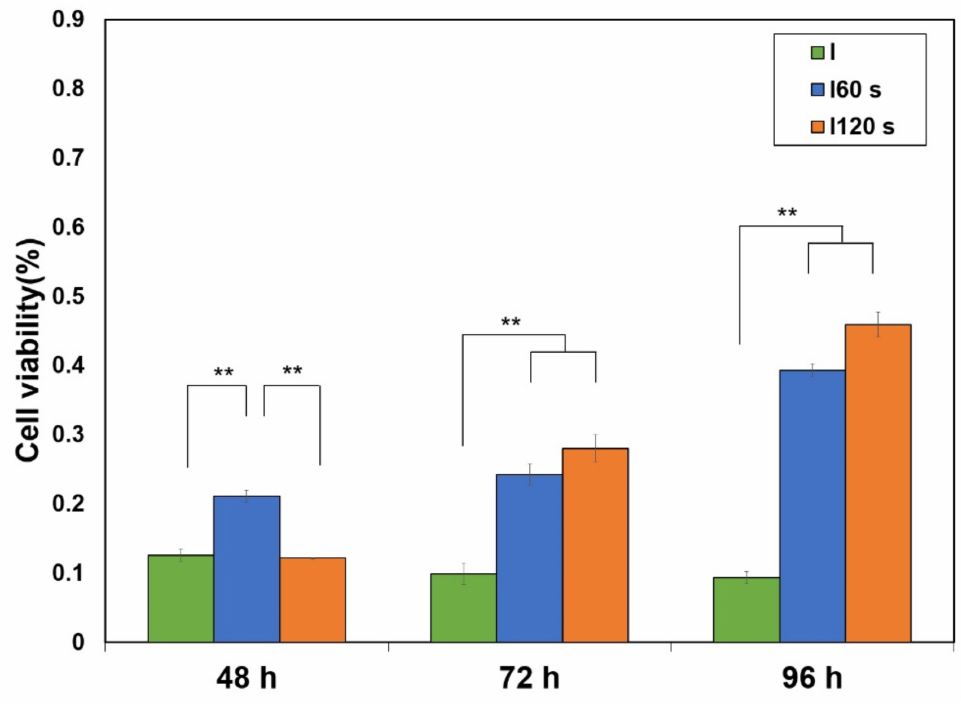
Figure 7. Evaluation of MC3T3-E1 cell viability. **: Significant difference at p < 0.017.